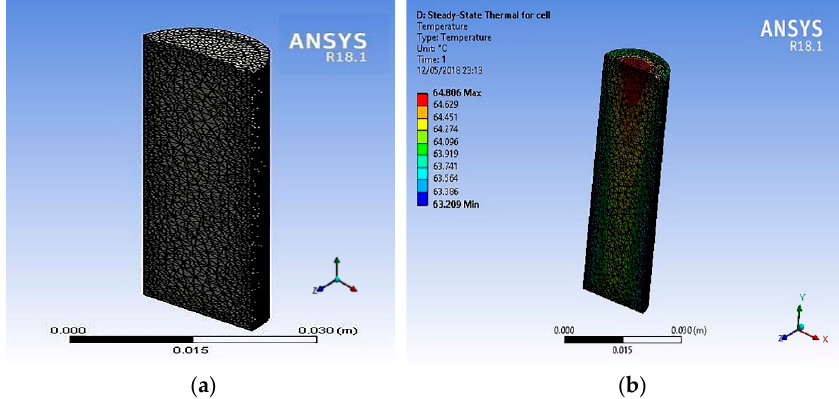
Figure 5. ( a ) Tetrahedral meshing and ( b ) steady-state thermal analysis result showing the temperature gradient along the 18650 LIB for 2C dry discharge current (5 A).